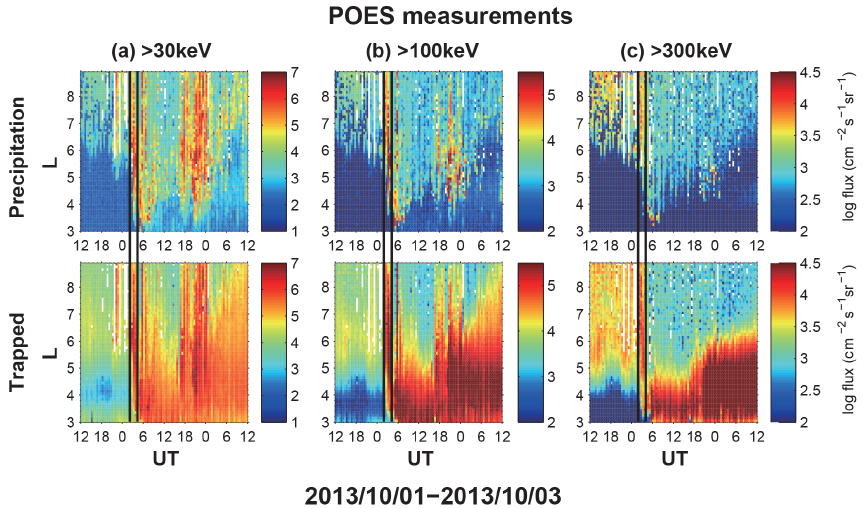
Figure 8. Temporal variations of (top) precipitated and (bottom) trapped electron fluxes measured by the MEPED instrument onboard four NOAA POES satellites, i.e., NOAA-15, NOAA-16, NOAA-18, and NOAA-19, for the indicated three energy channels (>30, >100, and >300keV). The two vertical lines represent the start of the two intense P dyn enhancements. The color scale specifies the logarithmic values of electron fluxes.